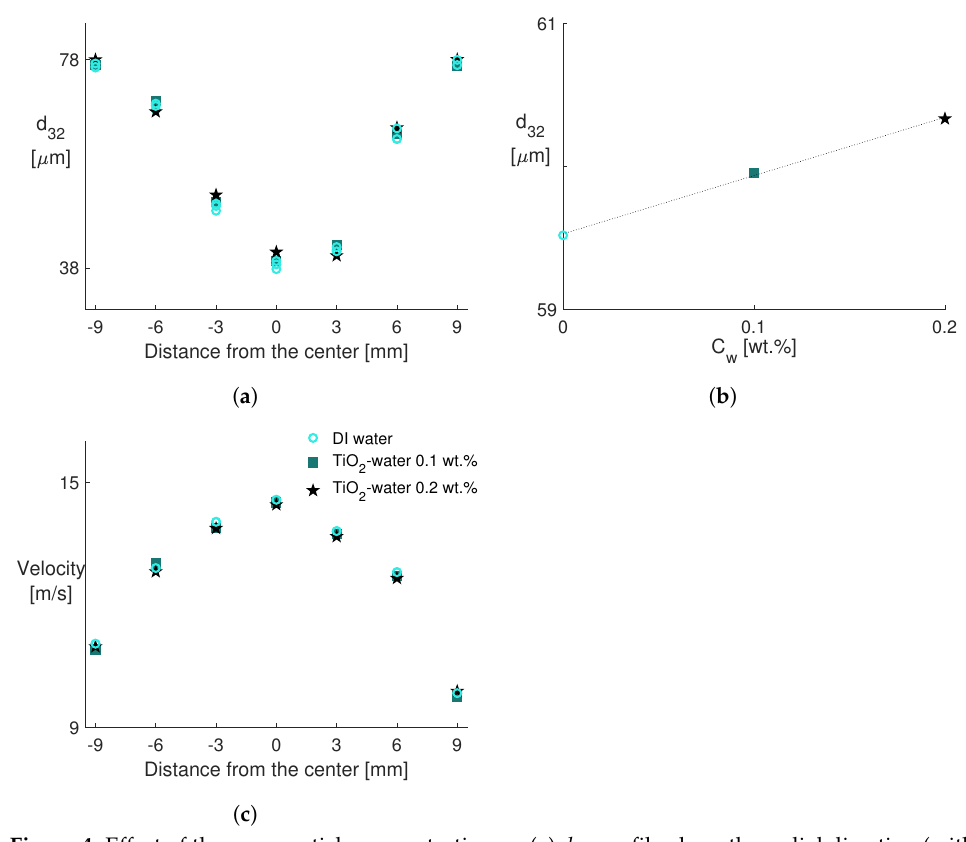
Figure 4. Effect of the nanoparticle concentration on ( a ) d 32 profile along the radial direction (with 3 types of repeatability test data for DI water), ( b ) averaged d 32 along the radial direction as a function of C w , and ( c ) velocity profiles. The same legend applies to all